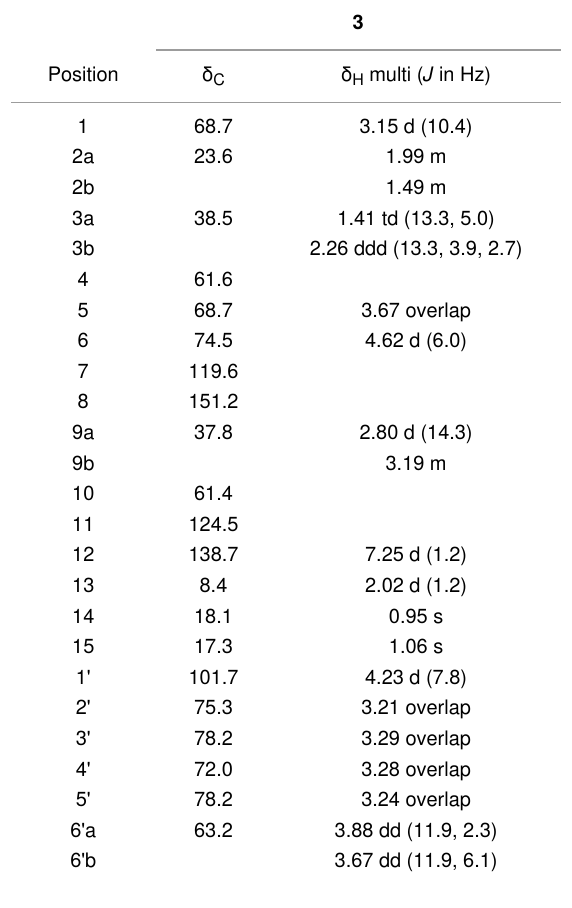
Table 2: 1 H (700 MHz) and 13 C (175 MHz) NMR data of compound 3 in methanol- d 4